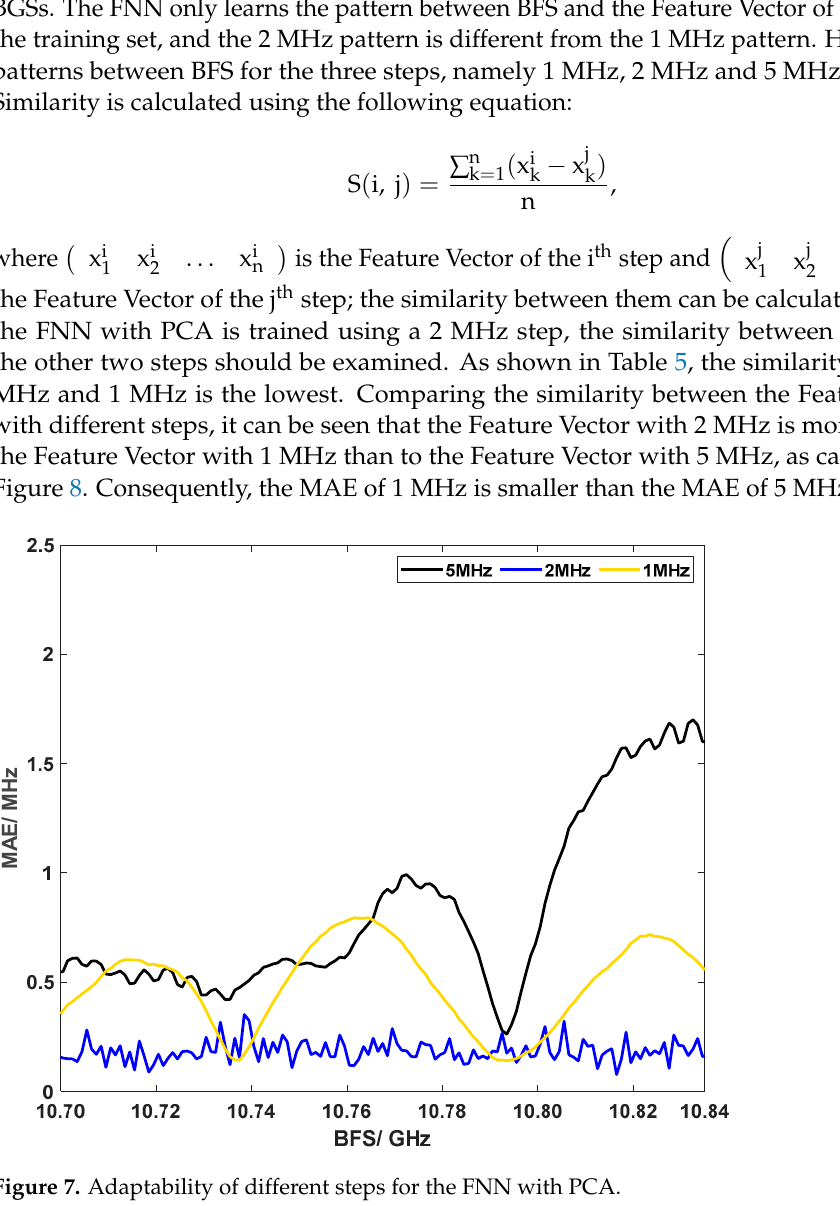
0.4888 MHz Figure 8. Results of vector subtraction between 10-dimensional Feature Vectors of different steps are visually shown. The smaller the magnitude of vector subtraction, the more similar the two feature vectors of different steps.